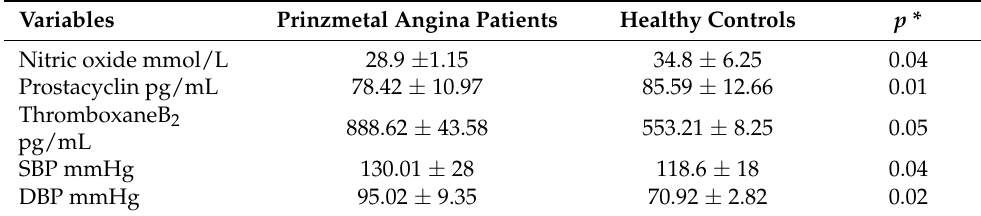
Table 2. Serum Nitric oxide, Prostacyclin, and Thromboxane B 2 , and blood pressure in study